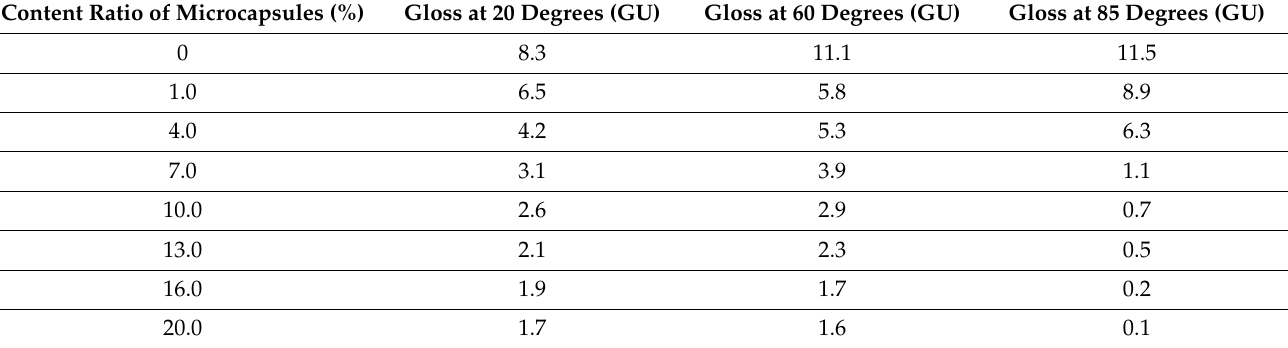
Table 3. Gloss performance table with core ratio of